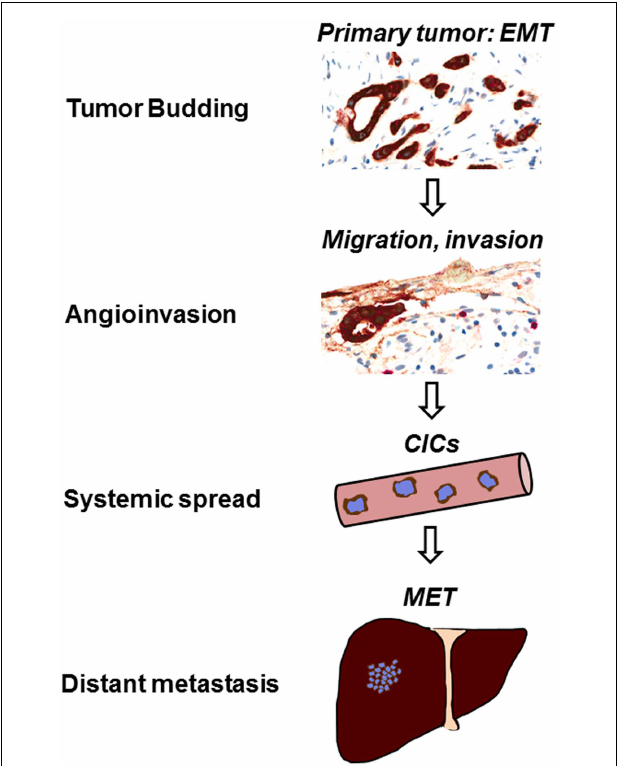
FIGURE 1 |Tumor budding . (A) High-power image (250 × ) of tumor budding at the invasive front of colorectal cancer as visualized by pancytokeratin (brown) immunohistochemistry. (B) Tumor buds as seen in a standard hematoxylin and eosin (H&E) stain (250 × ).